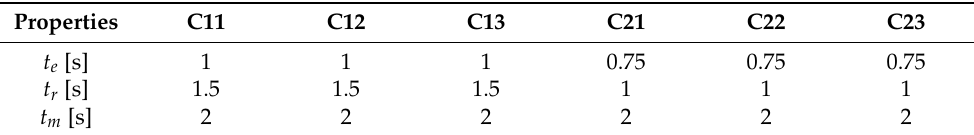
Table 3. Simulation times. t e = time for a statistically steady flow, t r = travel time for a steady flow of particles y t m = sampling